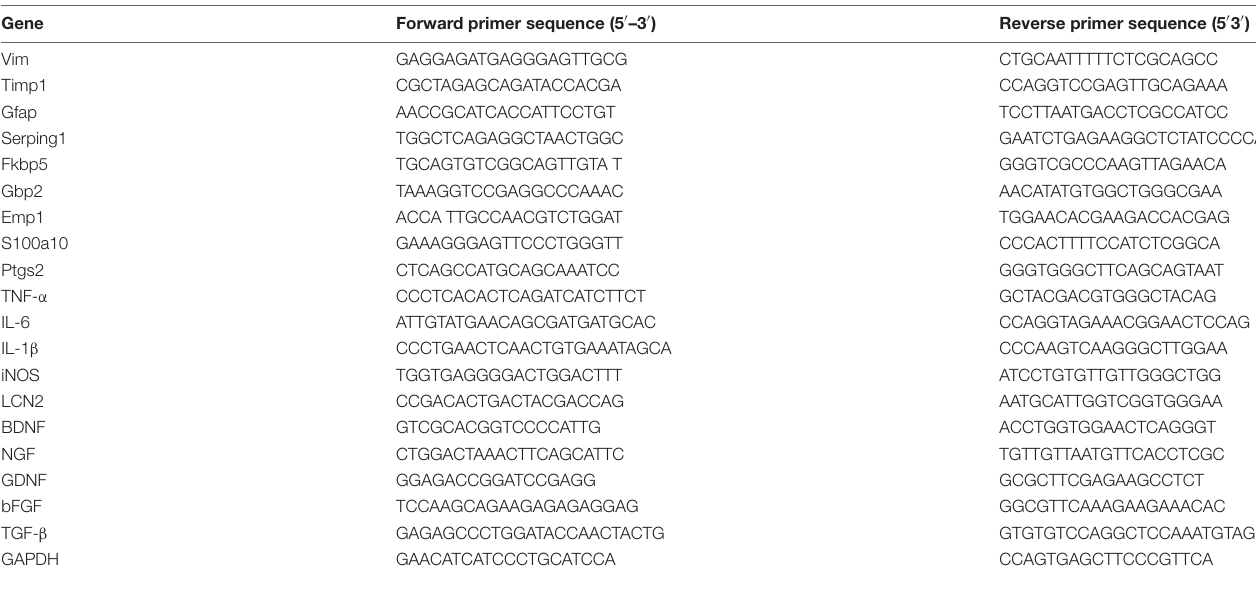
TABLE 1 | Primer sequences used for